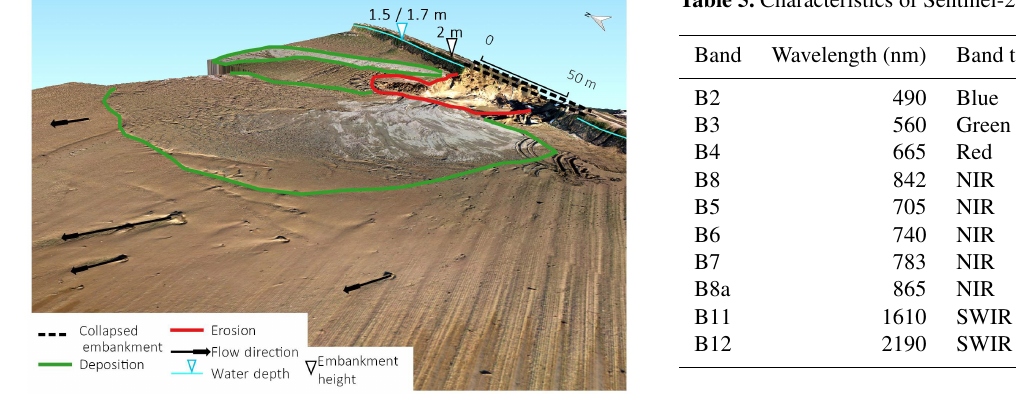
Table 5. Characteristics of Sentinel-2 data used in this